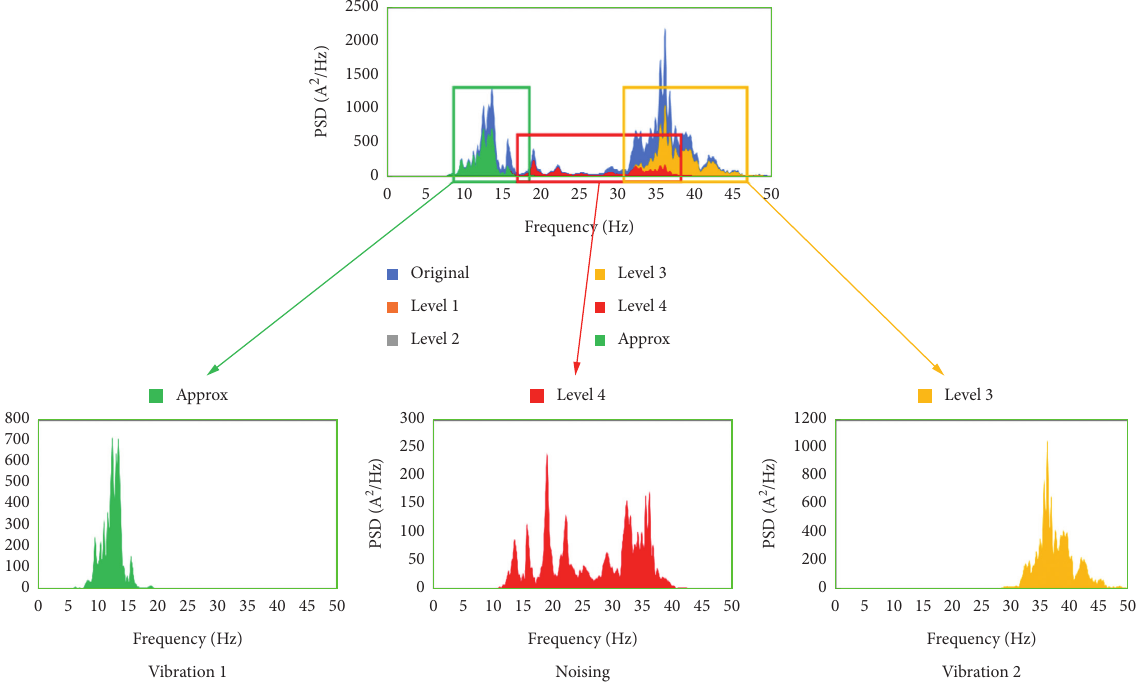
Figure 4: Separation of power density spectrum.